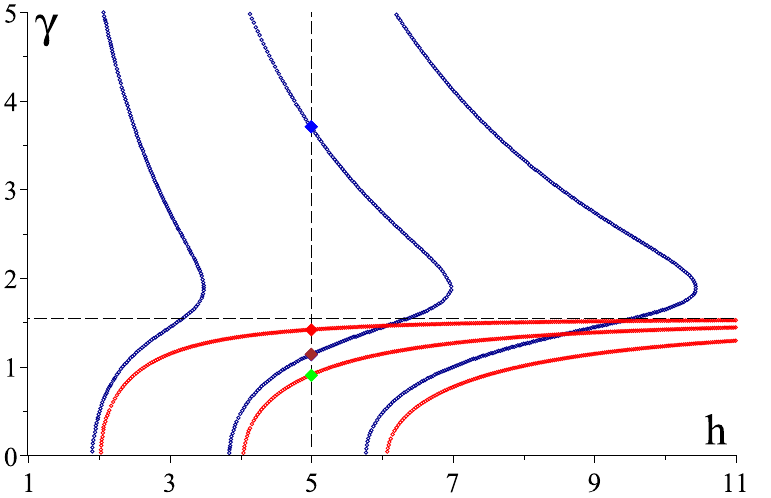
Figure 2. Dispersion curves of problem diamonds denote the propagation constants (cid:101) γ 1 β = 0 and propagation constants γ 2,1